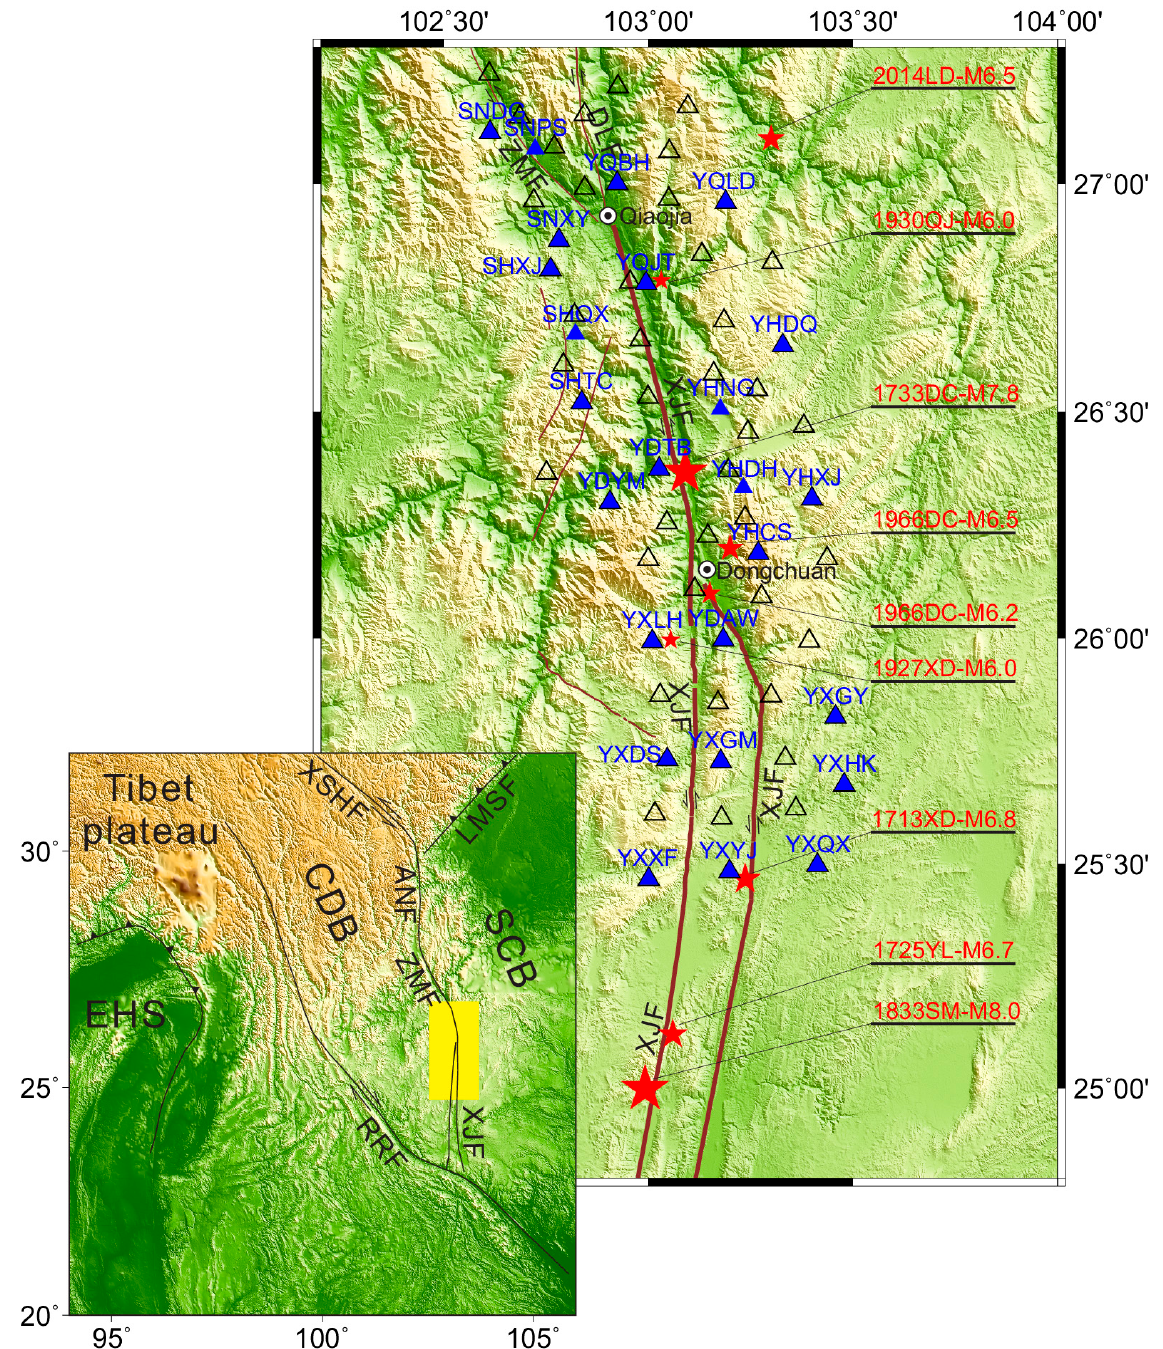
Figure 1. Distribution of the GNSS stations (blue triangles) and seismic stations (black empty triangles) in the northern and central sections of the Xiaojiang fault (XJF). Brown solid lines emphasize the XJF, and the red stars denote the M > 6 historical earthquakes since 1500. The subplot in the lower left corner shows the area of the main plot (yellow rectangle) with respect to the Chuandian Block (CDB) and the South China Block (SCB). Abbreviations: XSHF, Xianshuihe fault; ANF, Anninghe fault; ZMF, Zemuhe fault; XJF, Xiaojiang fault; DLF, Daliangshan fault; LMSF, Longmenshan fault; RRF, Red River fault; SCB, South China block; CDB, Chuandian block; EHS, Eastern Himalayan Syntaxis. Abbreviations in earthquake names: LD, Ludian; QJ, Qiaojia; DC, Dongchuan; XD, Xundian; YL, Yiliang; SM,